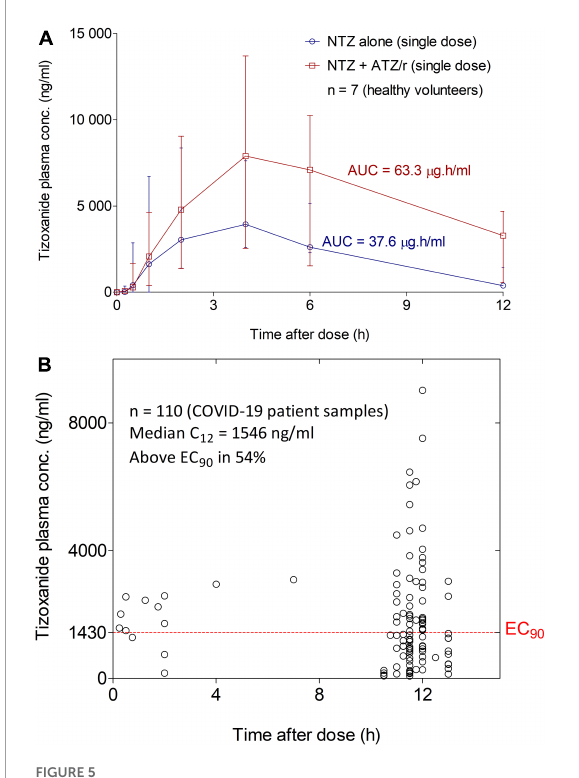
FIGURE5 Tizoxanide Concentration-time profiles in healthy volunteers and plasma concentration in COVID-19 patients. (A) Co-administration of nitazoxanide (NTZ) with atazanavir/ritonavir (ATZ/r) increased plasma tizoxanide AUC0-12 by 68.3% (37.6 µ g.h/ml vs. 63.3 µ g.h/ml) and its Cmax by 14.4% (7,630 ng/ml vs. 8,730 ng/ml). (B) Using samples collected at 11–12 h after the last nitazoxanide dose (1,000